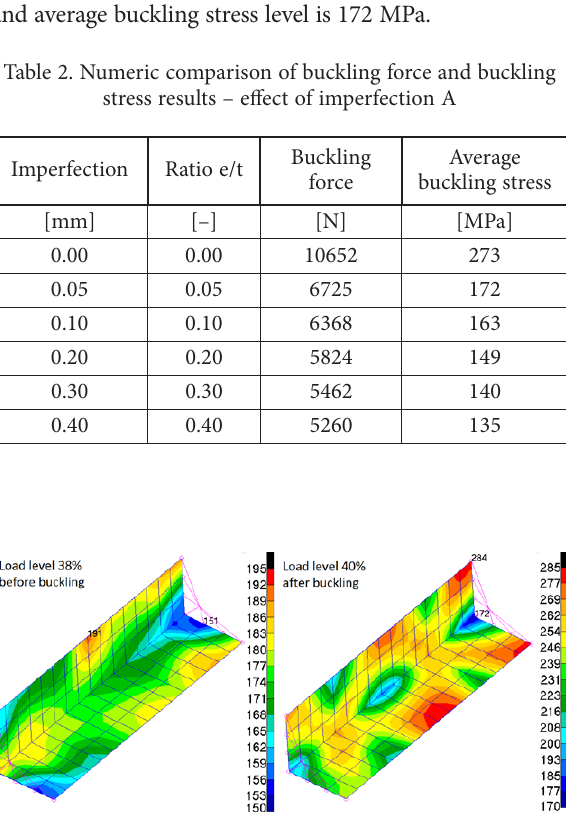
Figure 3. Graphic visualization of von Mises stress distributions on FE model with imperfection